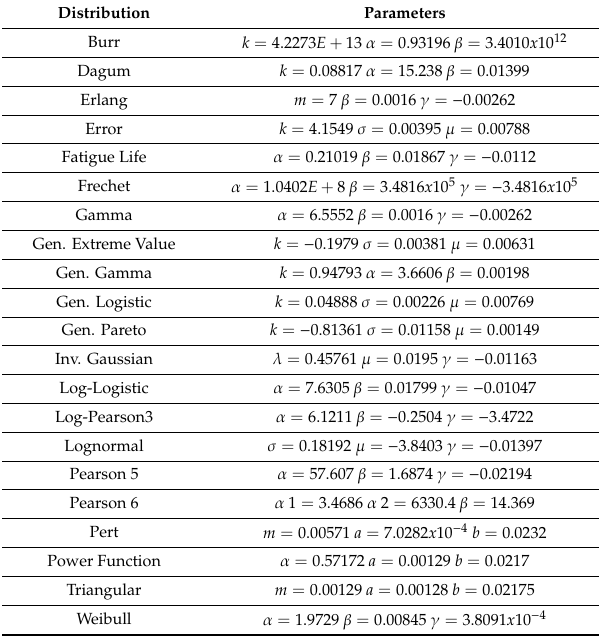
for IBP where T cl = 4 d 0